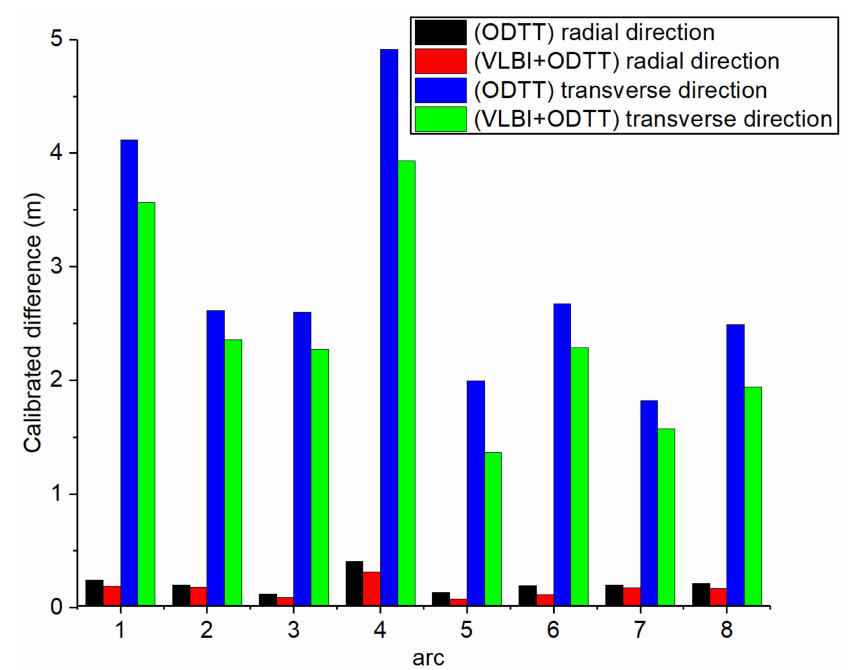
Figure 7. The bias in the transverse and radial